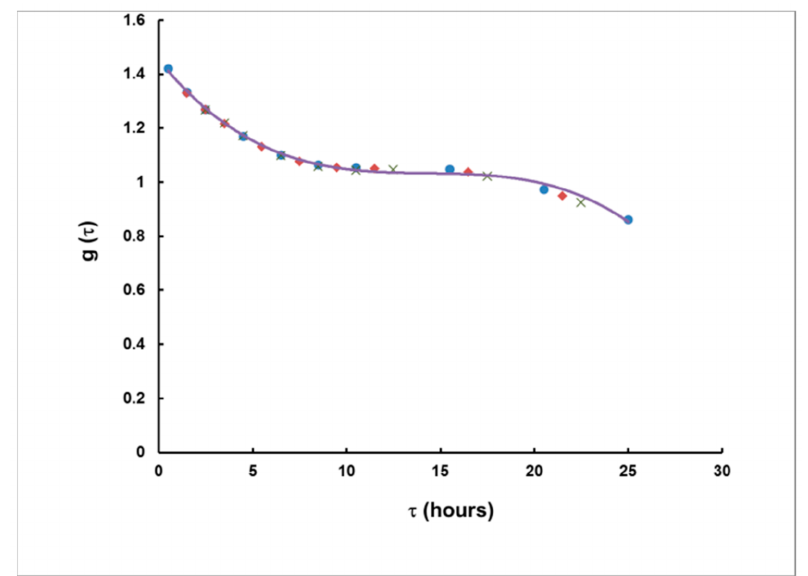
Figure 6. The corrective function g as a function of τ . Points correspond to rectangular plumes of duration 1 h ( • ), 3 h ( (cid:7) ) and 5 h ( × ). The solid curve represents a third-degree polynomial fit to the data points (Equation